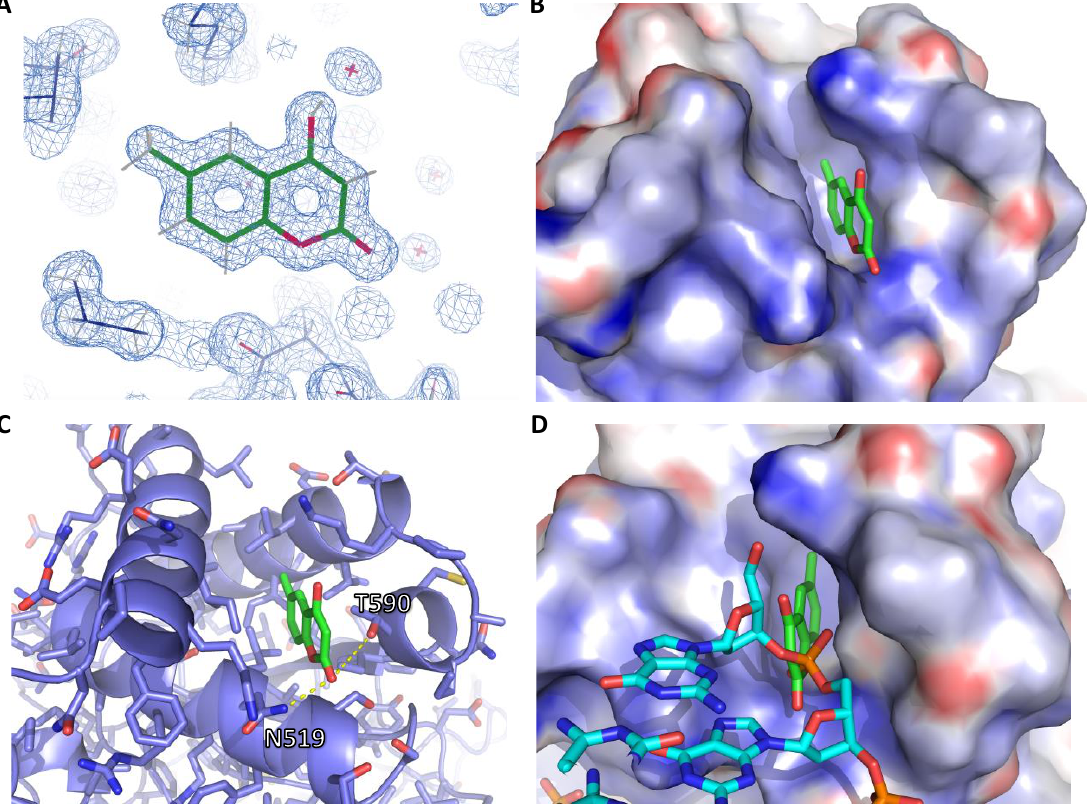
Figure 4. High-resolution crystal structure of EBNA1 bound to AC37287. ( A ) 2F o –F c electron density map of AC37287 (green). The map was contoured at 1.0 σ . ( B ) Electrostatic surface representation of AC37287 bound to EBNA1. ( C ) Cartoon and stick representation showing hydrogen bonding interaction between D519 and AC37287. ( D ) Superposition of DNA structure on the crystal structure of AC37287 bound to EBNA1.